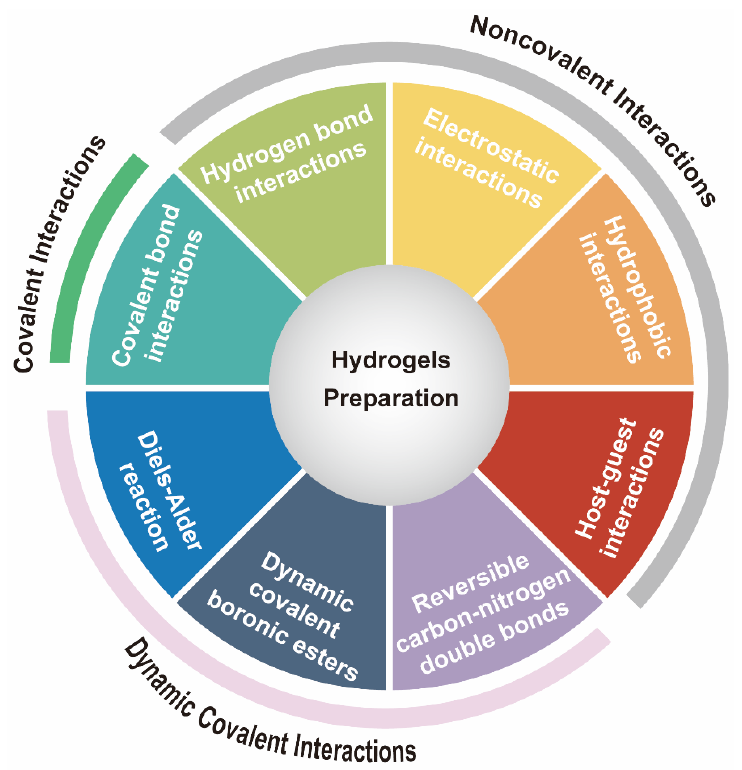
Figure 1. Gelation mechanisms for producing hydrogels.